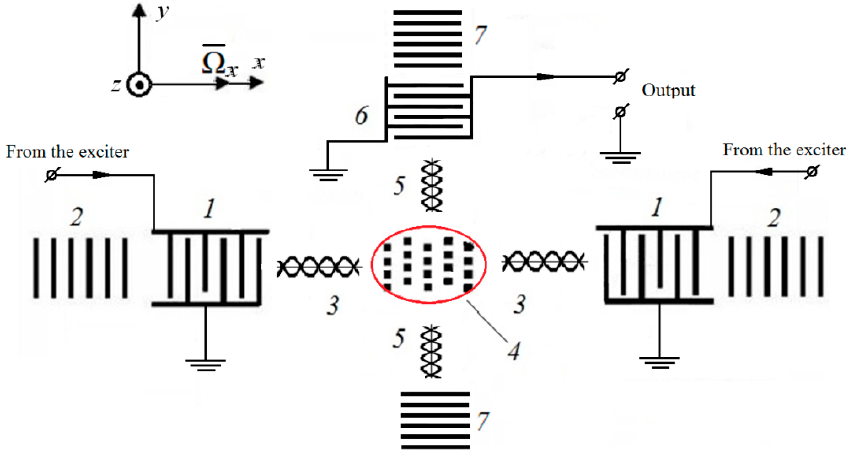
Figure 1. Scheme of the sensitive element of a SAW-based solid-state microgyroscope with cross-links and a matrix of inertial masses.